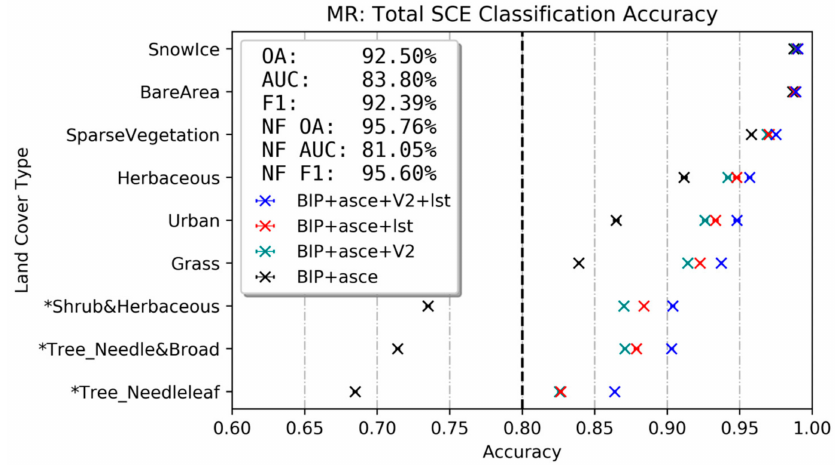
Figure 1. Assessment of the influence of di ff erent input combinations on the performance of the model for the Monte Rosa (MR) region. Di ff erent classification accuracies based on di ff erent input combinations are marked in di ff erent colors, and the accuracy for each land cover class is marked in the same horizontal axis. SAR-based observations, including backscatter, interferometric SAR (InSAR) coherence, and polarimetric (PolSAR) H / A / α parameters are abbreviated as B, I, and P, respectively. Topographical factors, including aspect, slope, curvature, and elevation are abbreviated as a, s, c, and e, respectively. Two vegetation indexes and land surface temperature are abbreviated as V2 and lst, respectively. Non-forest classes’ overall accuracy, F measure, and area under the receiver operating characteristic curve are abbreviated as NF OA, NF F1, and NF AUC,